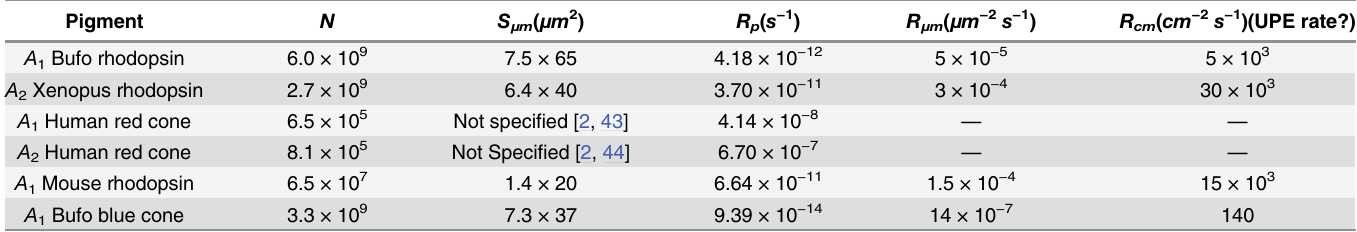
Table 6. The experimental measured rates of retinal discrete dark noise in Luo et al ’ s paper [2] are converted to the unit of ( cm − 2 s − 1 ) to be com- pared with the rates of UPE. The rates are calculated as R cm = 10 8 R μ m in which R m m ¼ NR p where S μ m is the area of the measured segment (in terms of S m m μ m 2 ), S cm is the area of the measured segment (in terms of cm 2 ), N is the number of pigments in the measured segment, R p is the rate constant per pigment (in terms of s − 1 ), R μ m is the rate constant in segment (in terms of μ m − 2 s − 1 ), and R cm is the rate constant in segment (in terms of cm − 2 s − 1 ). The results indicate that the obtained rates for dark noise are of the order of UPE rate (i.e. a few, up to 10 4 photons/( cm 2 s)). [18 – 24, 27, 31 – 37, 41, 42] This results indicate that the retinal discrete dark noise can be potentially due to spontaneous cellular UPE (or biophotons) in photoreceptor cells. Pigment